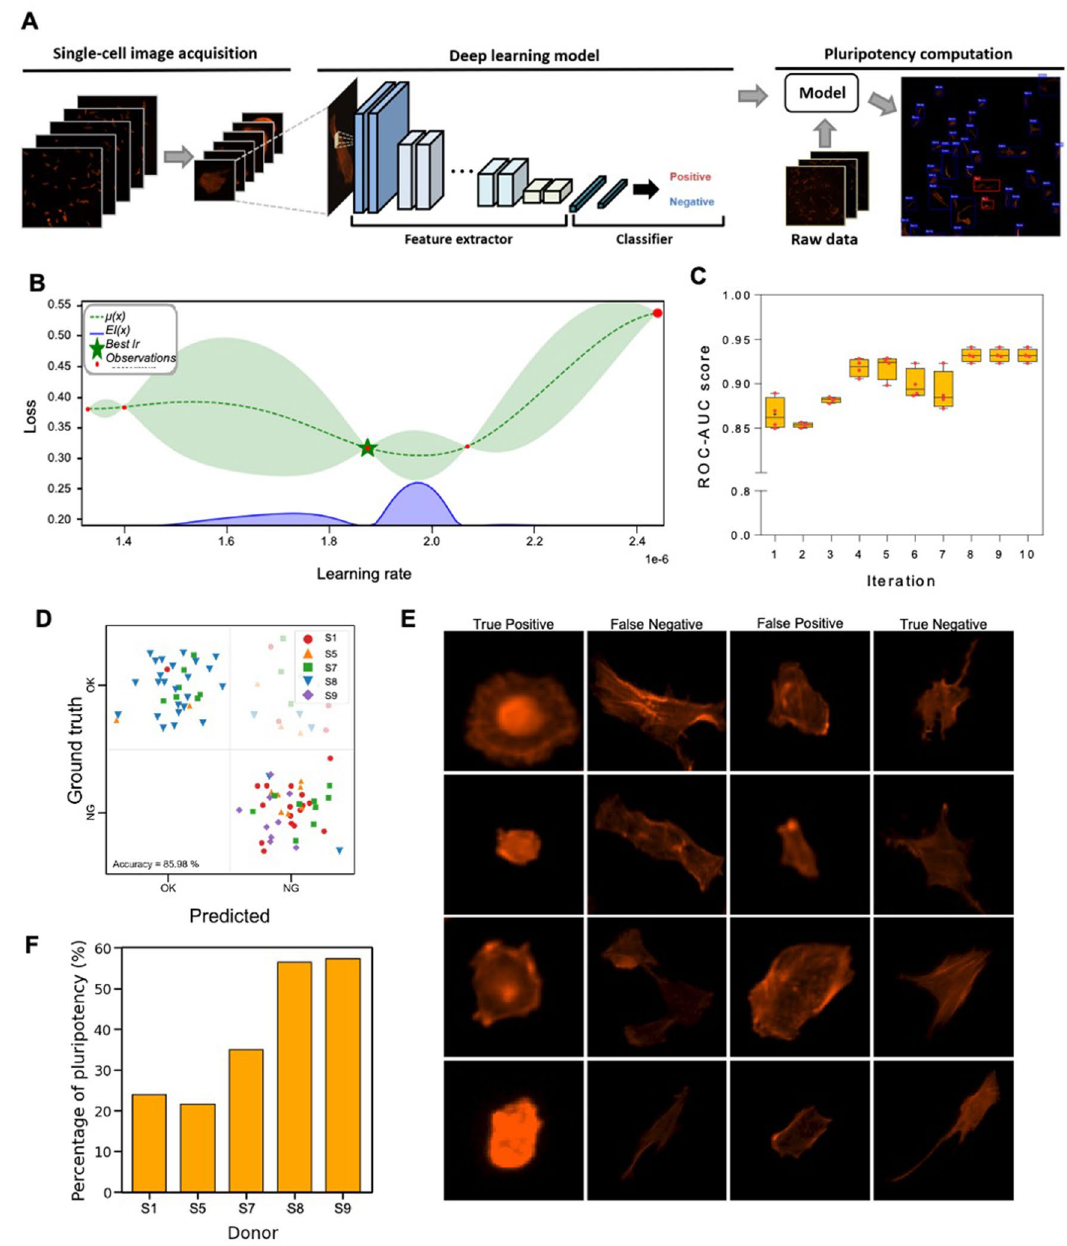
Figure 4. Deep learning-based multipotency prediction for hNTSCs from different donors. ( A ) Schematic images presenting the procedure of the proposed deep learning algorithm: single-cell image acquisition (preprocessing), deep learning model, and multipotency computation. ( B ) Bayesian optimization for learning rate: the results are visualized as a probabilistic model of the loss function (dotted line), uncertainty at each point (green region), and expected improvement (EI) for expensive optimization problems (blue region). ( C ) ROC-AUC score plotted over 10 iterations according to Bayesian optimization. ( D ) Confusion matrix: Predicted (x-axis) represents results through the deep learning; ground truth (y-axis) represents multipotency data revealed by immunofluorescence staining of SSEA3, and deep learning distinguishes cells with high/low multipotency. ( E ) Classification results of the proposed CNN model. ( F ) Ratio corresponding to the multipotent stem cell for each